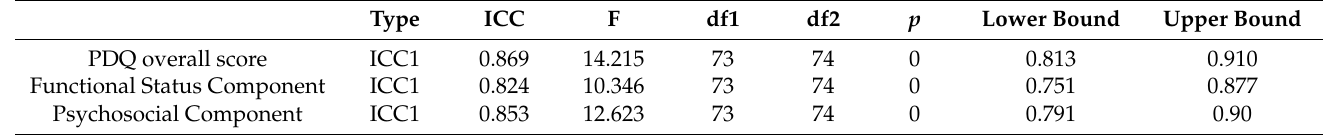
Table 4. Intraclass correlations (ICC) ( n =